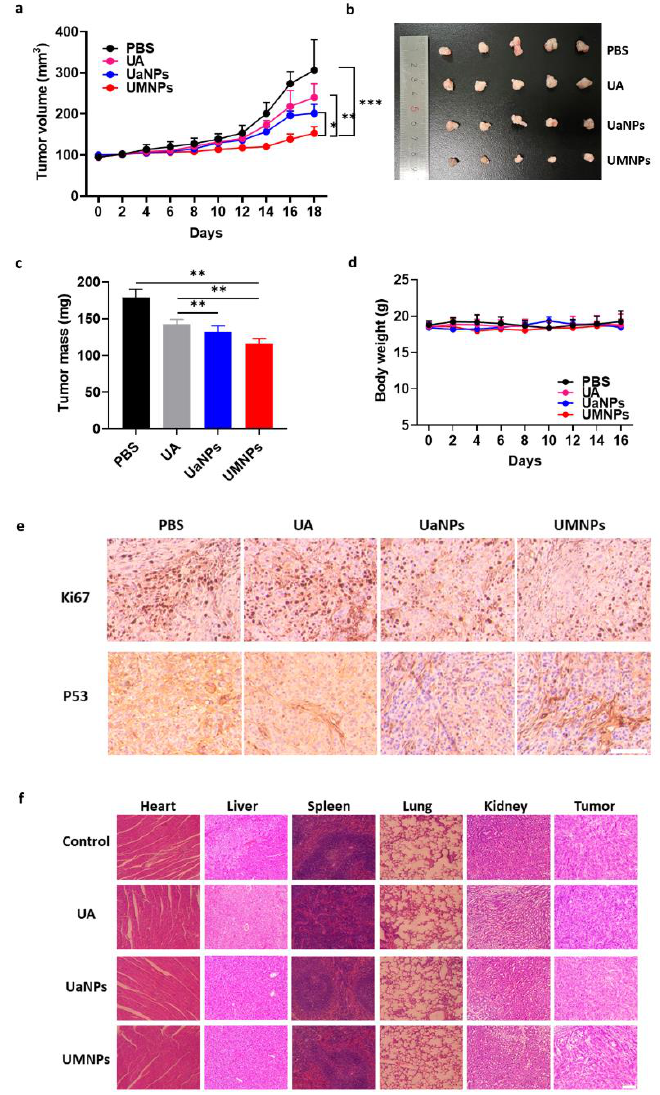
Figure 5. In vivo antitumor efficacy and biosafety of UA formulations. ( a ) Tumor volume of A549- bearing mice treated with different UA formulations over 16 days; ( b ) Images of tumor sections at the end of therapy period; ( c ) Weight of tumor sections in different groups at end of therapy period; ( d ) Body weight of A549-bearing mice treated with PBS, UA, UaNPs, and UMNPs; ( e ) IHC analysis of tumor tissues after treatment with different UA formulations. Scale bar = 200 μm; and ( f ) HE staining of heart, liver, spleen, lung, and kidney of mice treated with different UA formulations. Scale bar = 200 μm. Data presented as mean ± SD ( n = 5). Differences were considered significant when * p < 0.05, ** p < 0.01, or *** p < 0.001, respectively.